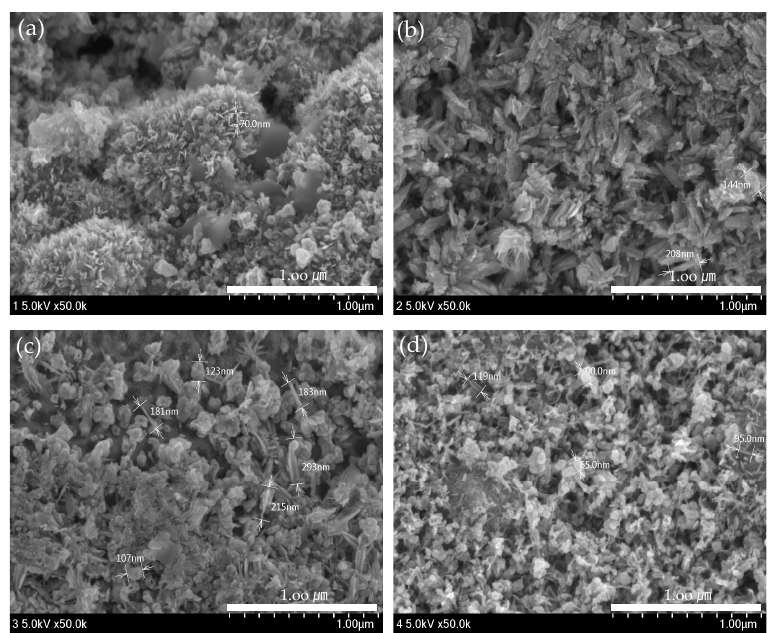
Figure 4. ZnO-TiO2 surface observed by FE-SEM. ( a ) ZnO(90%)-TiO2(10%) ( b ) ZnO(95%)-TiO2(5%) ( c ) ZnO(99%)-TiO2(1%) ( d ) ZnO(100%)-TiO2(0%).